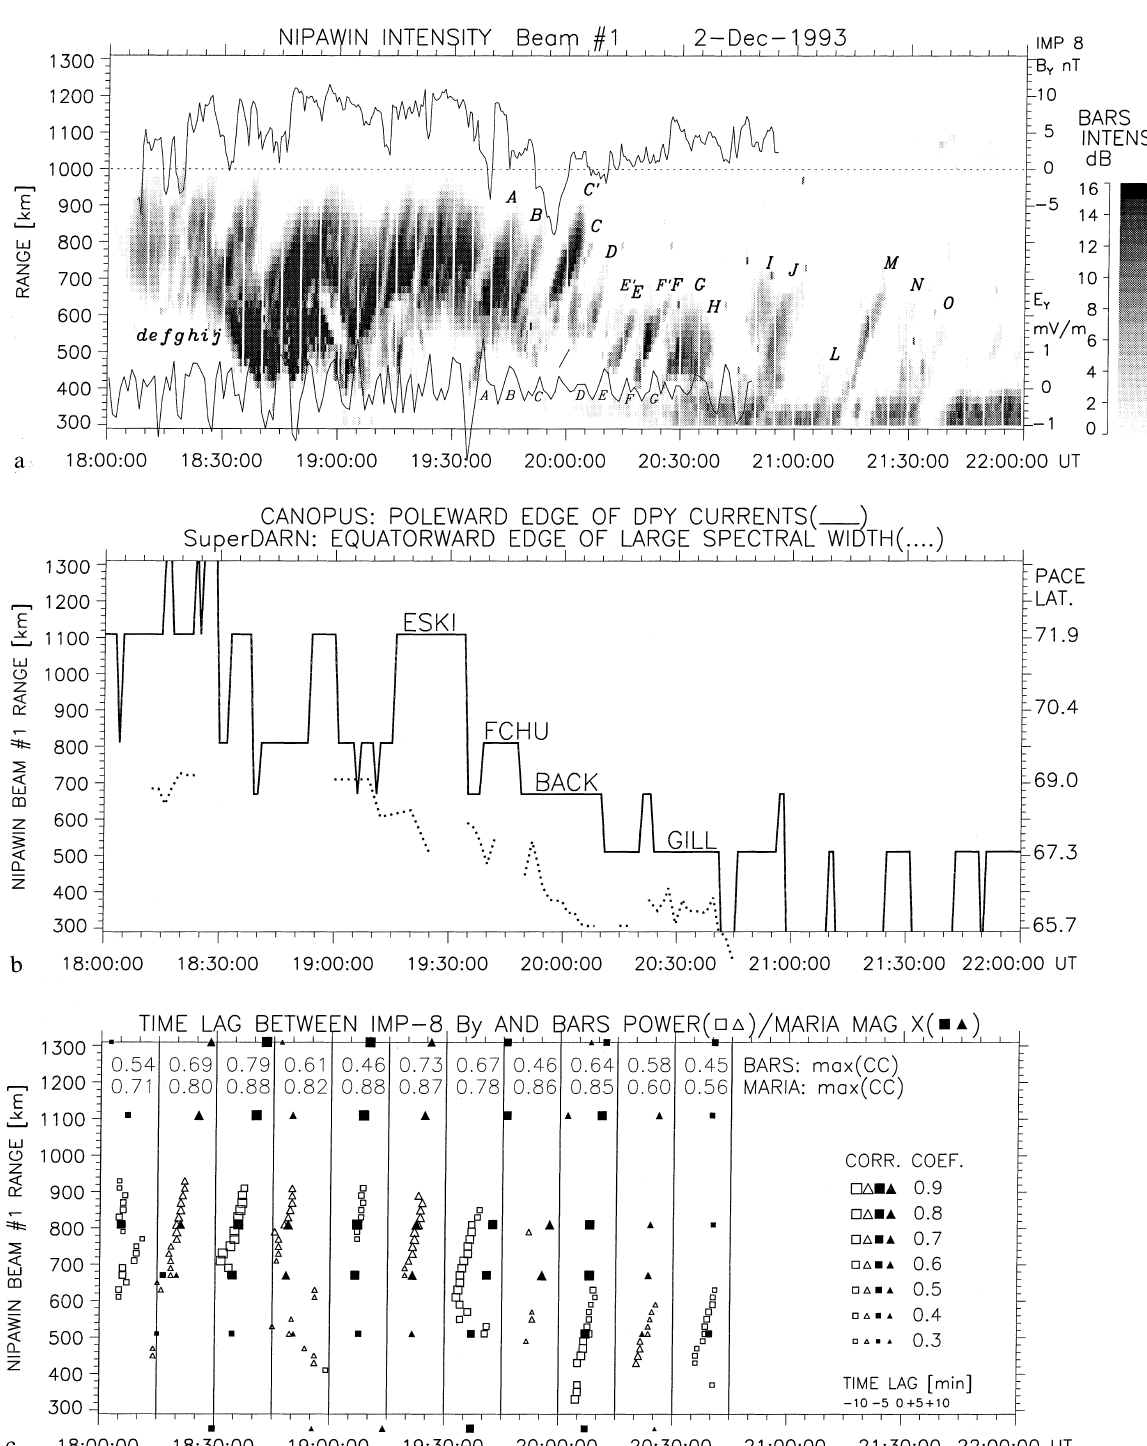
Fig. 6. a Range-versus-time plot of the Nipawin radar backscatter plotted. The vertical lines represent the zero delays and/or the start power. The poleward-progressing Pc5 FLR bands for two events are time for the corresponding window. The delays for the BARS power labeled. The IMP-8 IMF B component ( top ) shifted by 7 min and the ( open symbols ) and CANOPUS magnetometer X components ( solid y pure state filtered dawn-dusk electric field E (unshifted at the bottom ) symbols ) are plotted for correlation coe(cid:129)cients greater than 0.3. The y are shown. b An approximate position of the poleward edge of the largest values of the cross-correlation coe(cid:129)cient for BARS ( first row ) eastward DPY (Hall) currents and the equatorward boundary of large and MARIA ( second row ) are printed at the top for each window. The spectral widths measured by SuperDARN radars are mapped along first set of points ( squares ) is for the interval of 1800–1830 UT, the the Nipawin radar beam 1 ( leftmost beam). c Time delays between the second set of points ( triangles ) is for the interval of 1815–1845 UT, IMF B etc. A generic scale for time lags is shown ( bottom-right component and the ionospheric/ground signals obtained y from CCFs computed for 30-min windows stepped by 15 min are